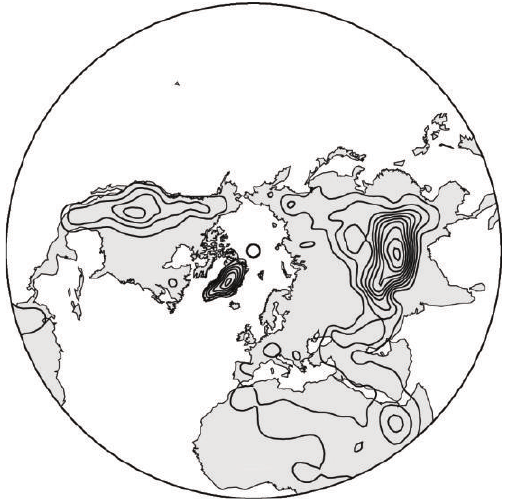
Figure 1: T63 orography of the NH. Contour interval is 500 m; zero contour